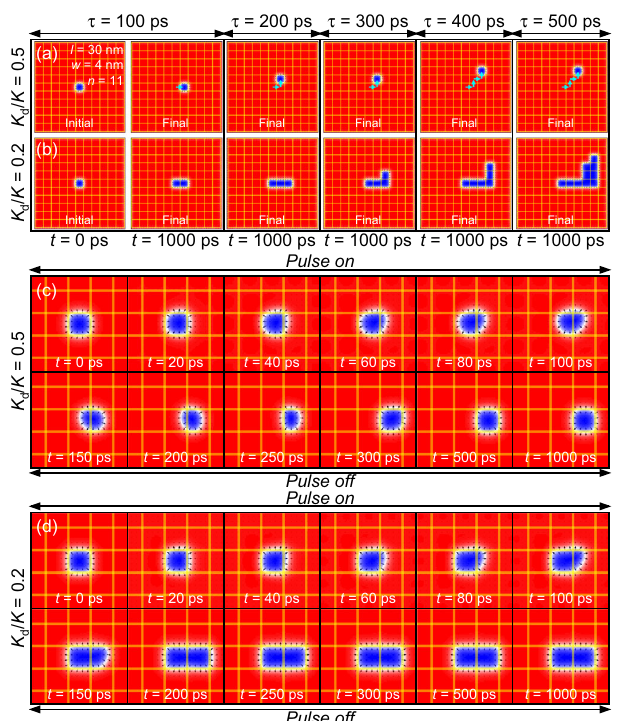
Fig. 4 Effect of pulse length on the current-induced dynamics of a square- shaped skyrmion. a Top views of the hopping motion of a square-shaped skyrmion driven by a current pulse with the pulse length τ . Here, l = 30 nm, w = 4 nm, n = 11, K K = 0.5, and the damping parameter α = 0.3. K and K d / d stand for the perpendicular magnetic anisotropy constants for the unmodi fi ed areas and defect lines, respectively. l denotes the spacing between two adjacent parallel defect lines. w denotes the width of the defect line. n denotes the number of unit square patterns along the x and y directions. The side length of the sample equals 378 nm. A square-shaped skyrmion with the topological charge of Q = 1 is relaxed at the sample center as the initial state at t = 0 ps. A current pulse of j = 100 MA cm − 2 and p ¼ (cid:2) ^ y is applied, and then the system is relaxed until t = 1000 ps. The defect lines with reduced K d are indicated by yellow lines. The motion route is denoted by the cyan arrow. b Top views of the deformation of a square-shaped skyrmion driven by a current pulse with τ . Here K d / K = 0.2. The other parameters are the same as those in ( a ). c Zoomed top views of the hopping motion of a square-shaped skyrmion driven by a 100-ps-long pulse of j = 100 MA cm − 2 . The other parameters are the same as those in ( a ). d Zoomed top views of the deformation of a square-shaped skyrmion driven by a 100-ps-long pulse of j = 100 MA cm − 2 . The other parameters are the same as those in ( b